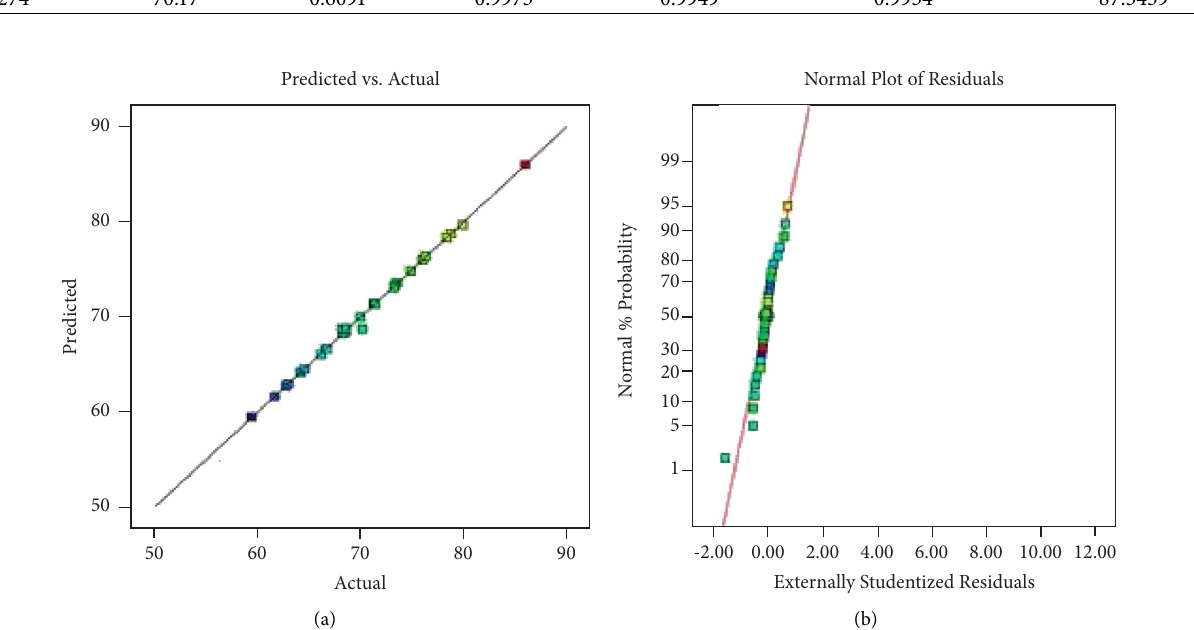
Table 4: Modified ANOVA of the fitted model for the yield of biosilica. Std. dev.